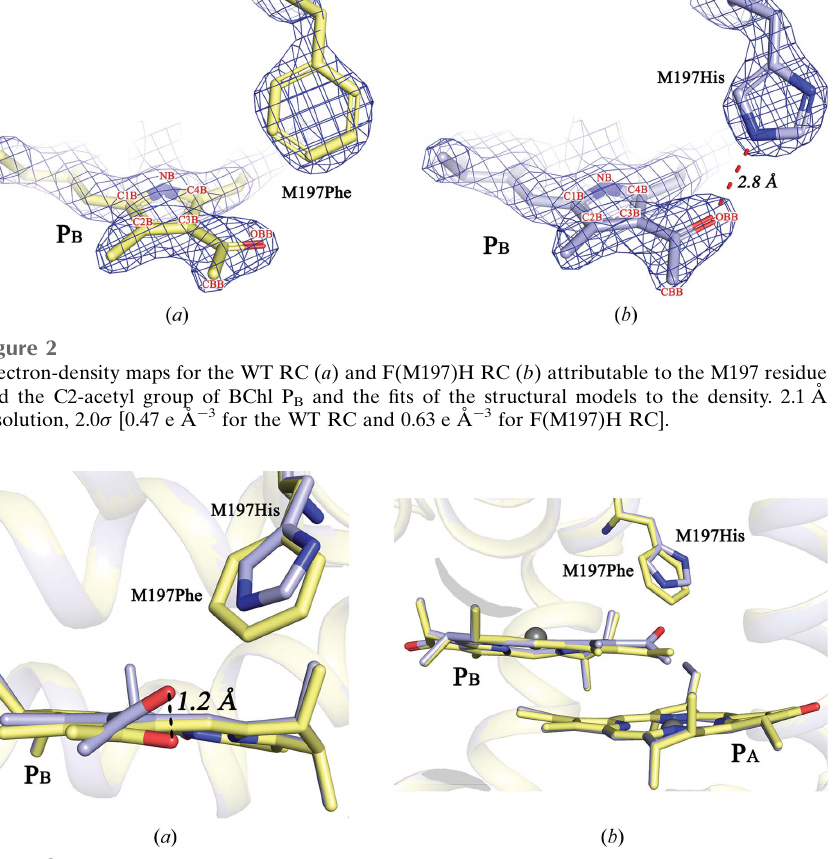
Figure 3 Superimposition of the C2-acetyl group of BChl P B in the WT RC (pale yellow) and in F(M197)H RC (light blue). Views of this group are shown along the plane of BChl P B ( a ) and perpendicular to the M197 imidazole ring ( b